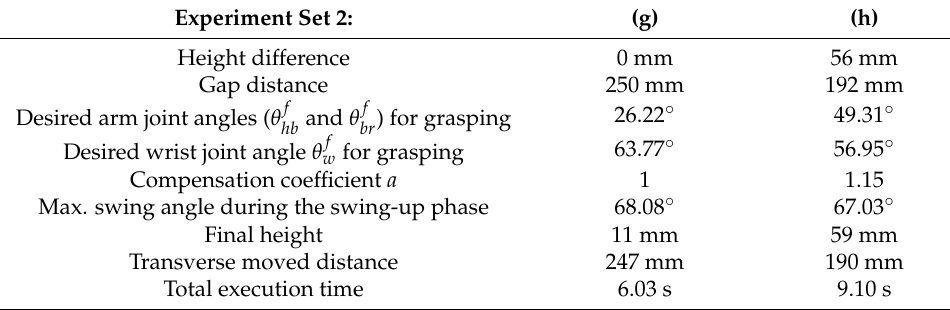
Figure 22. Setup used in second set of experiments: non-horizontal-elevation ledge brachiation. Table 5. Parameter settings used in the second set of experiments.